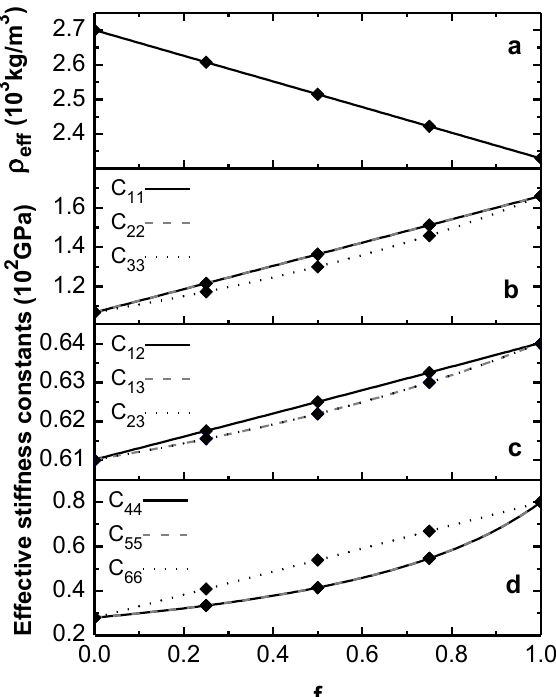
Figure 6. Comparison of the calculation of the effective parameters 𝜌̄ 𝑒𝑓𝑓 and 𝐶̄ 𝑒𝑓𝑓 obtained in the quasi-static limit for a one-dimensional phononic crystal. The lines correspond to the results obtained by other homogenization theories, while the dots indicate the values obtained by this inclusion discretization approach. There is a good agreement between the calculations.